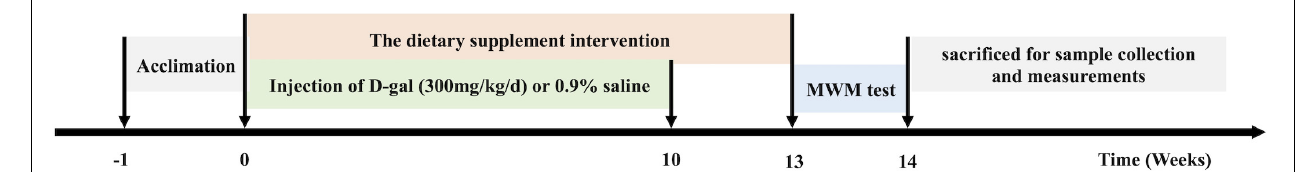
FIGURE 1 | The experimental protocol of the study. After 1 week of adaptation (week –1 ∼ 0), animal modeling (week 1 ∼ 10) and the dietary supplement intervention (week 1 ∼ 13) were introduced simultaneously. After 12 weeks of supplementation, we performed the Morris water maze test (week 13), including 5 days of place navigation test and 1 day of spatial probe test. After the Morris water maze test, the rats were fasted overnight and sacrificed for subsequent